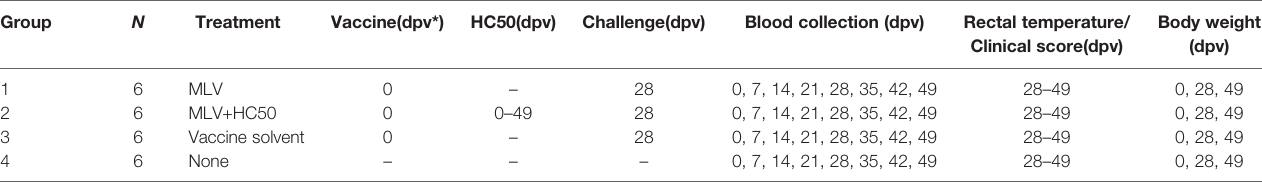
TABLE 1 | Summary of the in vivo